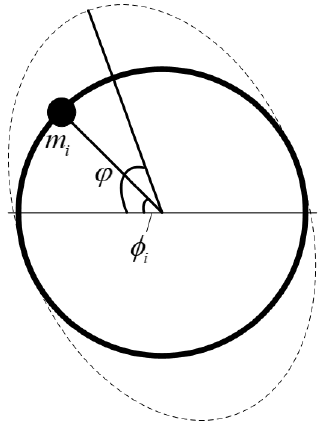
Figure 2. Perfect ring resonator adding mass points.